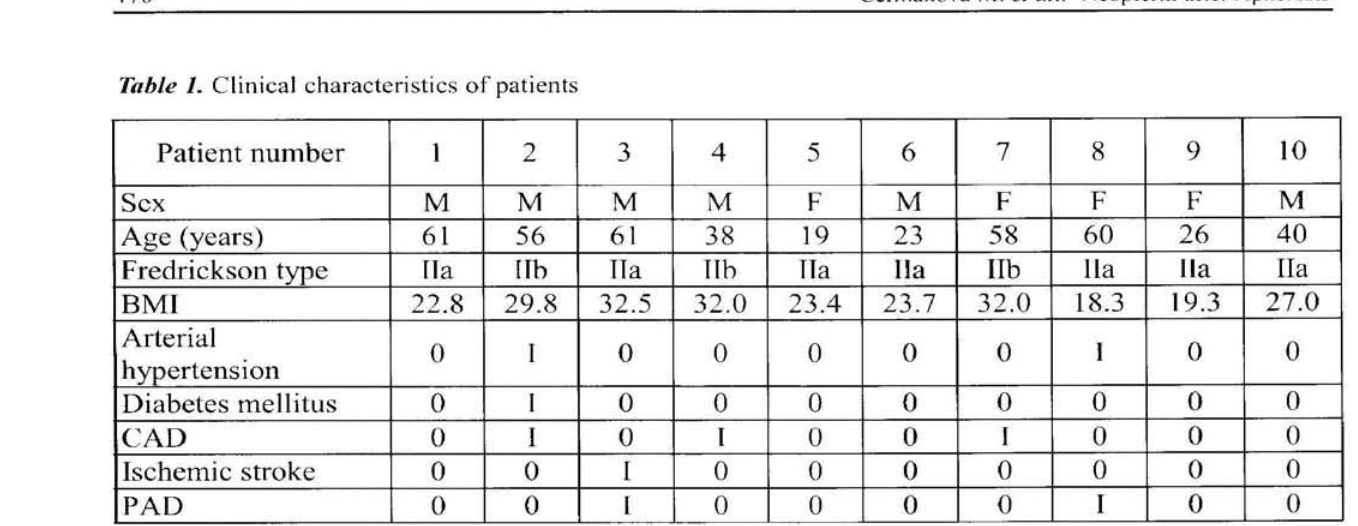
Table 1. Clinical characteristics of